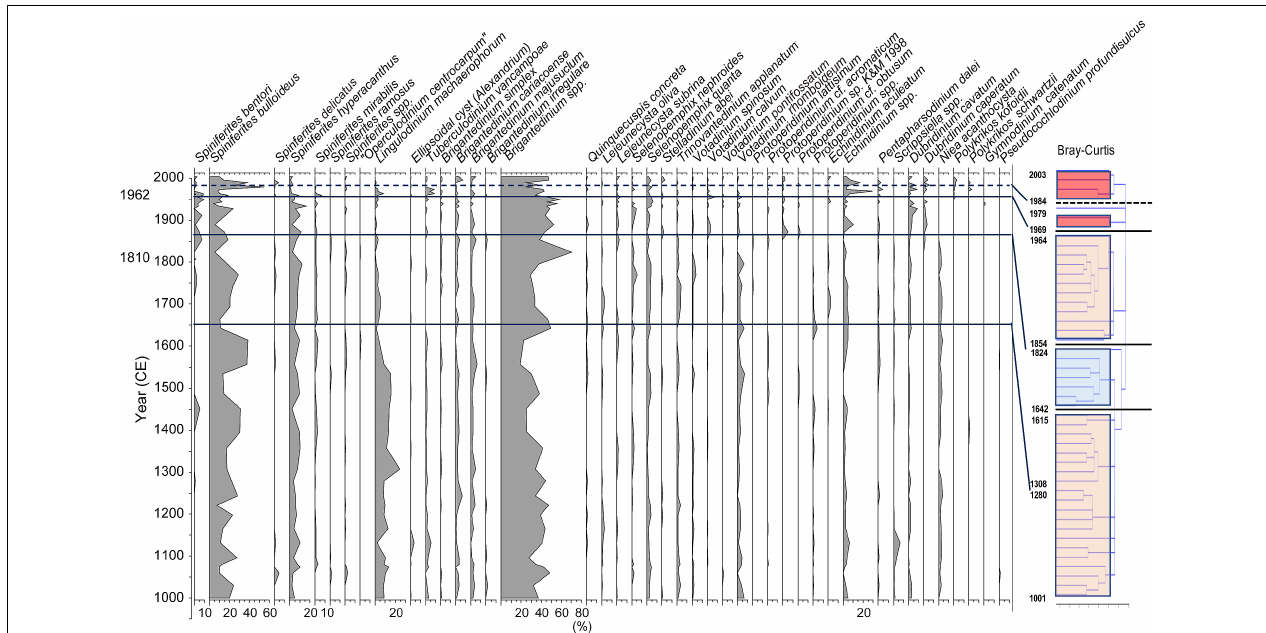
FIGURE 5 | Stratigraphic distribution of major groups of dinoflagellate cysts and Unit division based on stratigraphic cluster analysis using Bray-Curtis method.